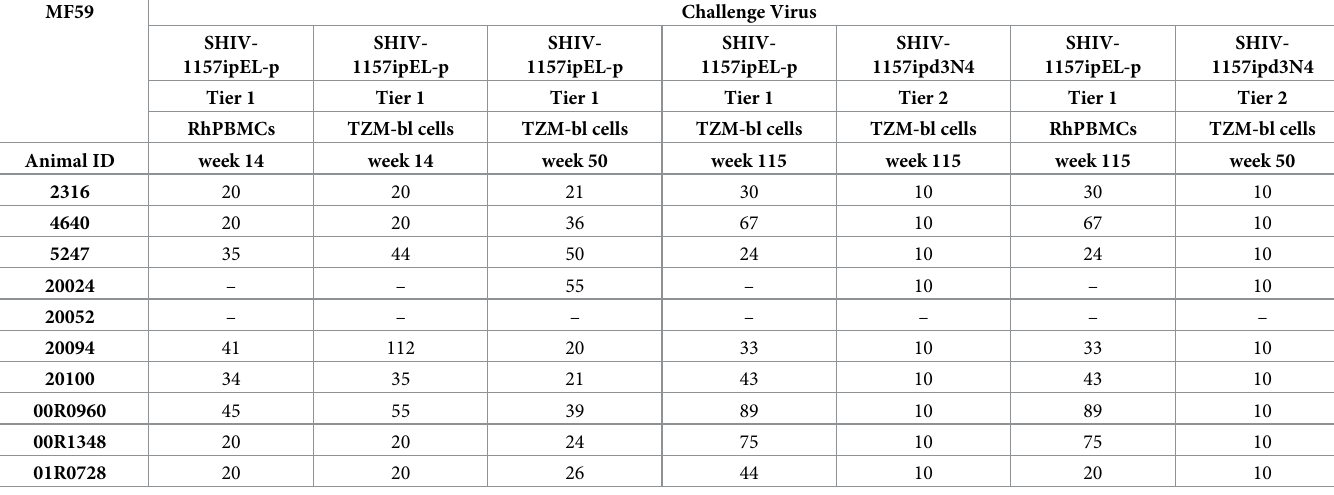
Table 7. Serum neutralizing activity against SHIV-C challenge stocks in animals immunized in Study 3 (MF59).